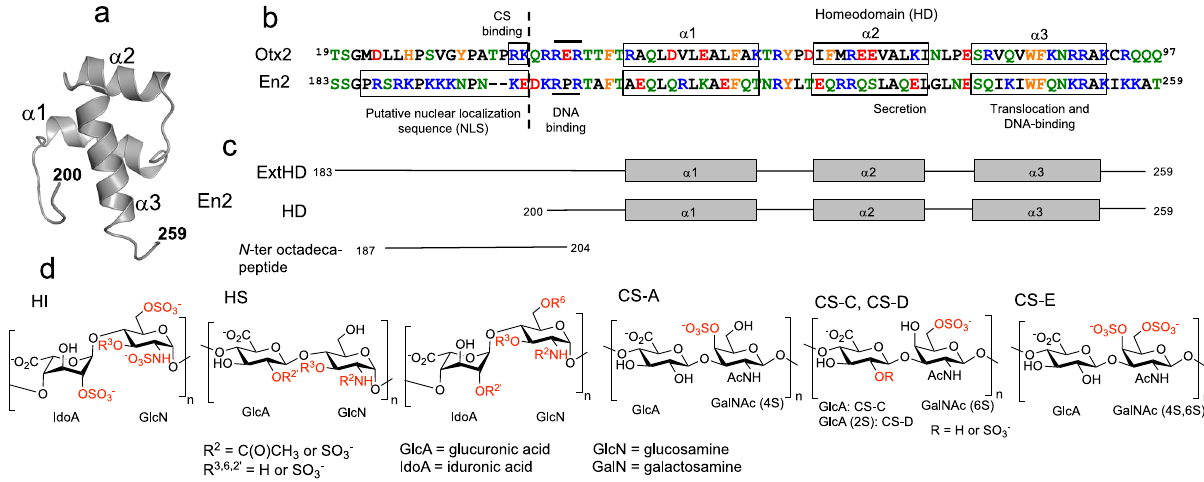
Fig. 1 | Structure and recognition sequences of En2 region 183-259. a Solution structure of the homeodomain of chicken En2 4 (region 200-259, PDB code 3ZOB). b Sequence alignment of En2 region 183-259 ( chicken gene numbering) with Otx2 region 19-97 (numbering is identical for chicken and mammals). Note that these regionsarestronglyconserved(99%sequenceidentitybetween chicken and human En2, and 100% sequence identity between chicken and human Otx2). Positively